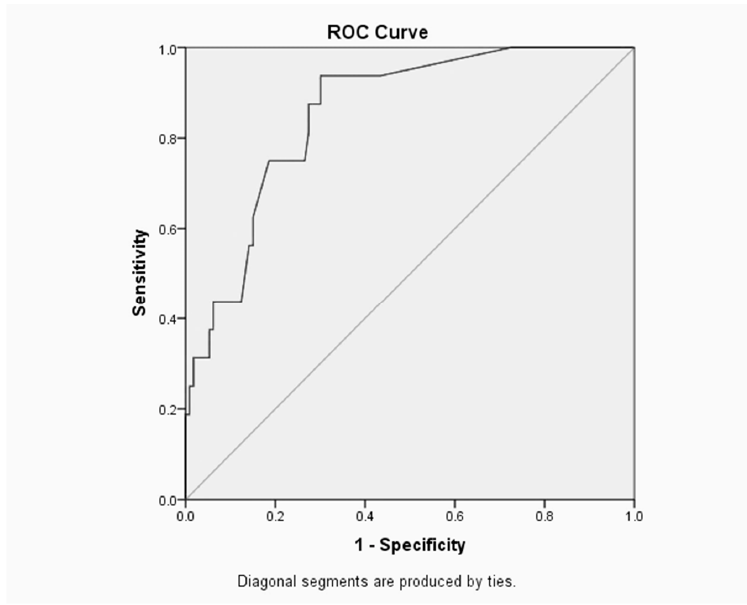
Figure 1. Receiver Operating Characteristic (ROC) Curve and Area for the Infant Binary Logistic Regression Model.